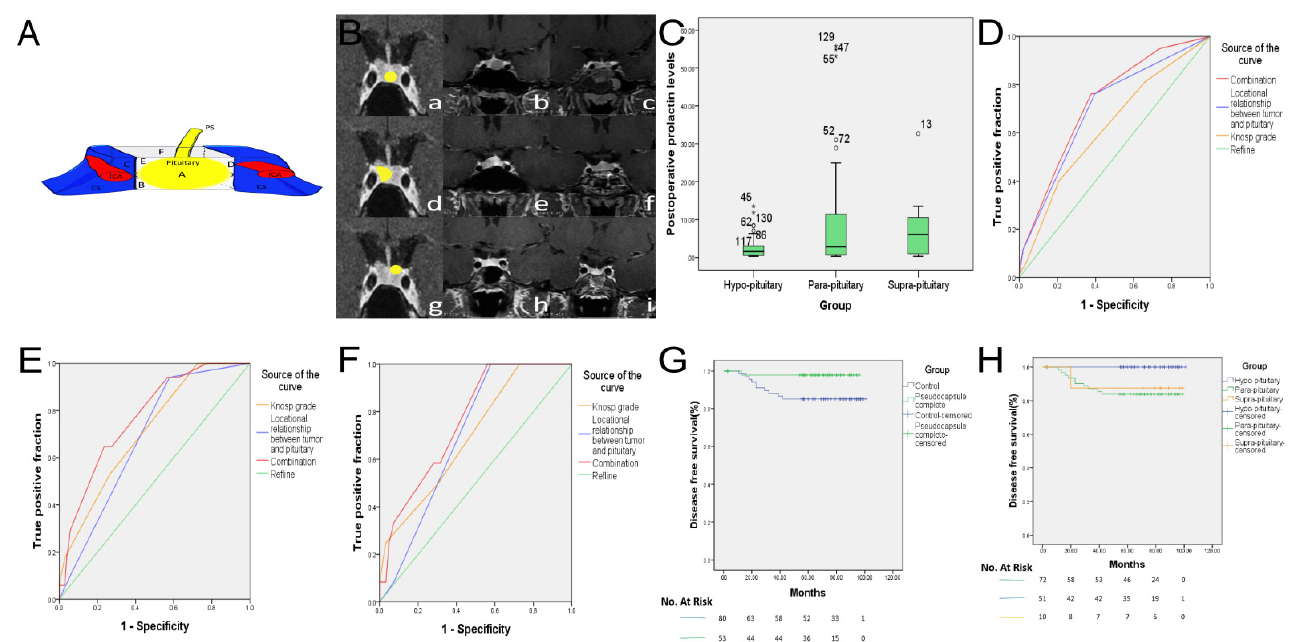
Figure 2. ( A ) PS—pituitary stalk; ICA—internal carotid artery; CS—cavernous sinus; side A—anterial wall of sella; side B—sellar floor; side C—lateral left side; side D—lateral right side; side E—sellar dorsum; side F—supra sellar. This is an anatomic pattern of the sellar region show-